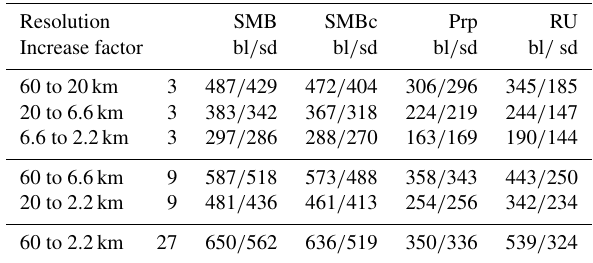
Table 3. Root-mean-square differences (RMSDs, mmw . e . a − 1 ) of bilinear (bl) and statistically downscaled (sd) variables for all res- olution combinations. SMBc denotes component-wise processed